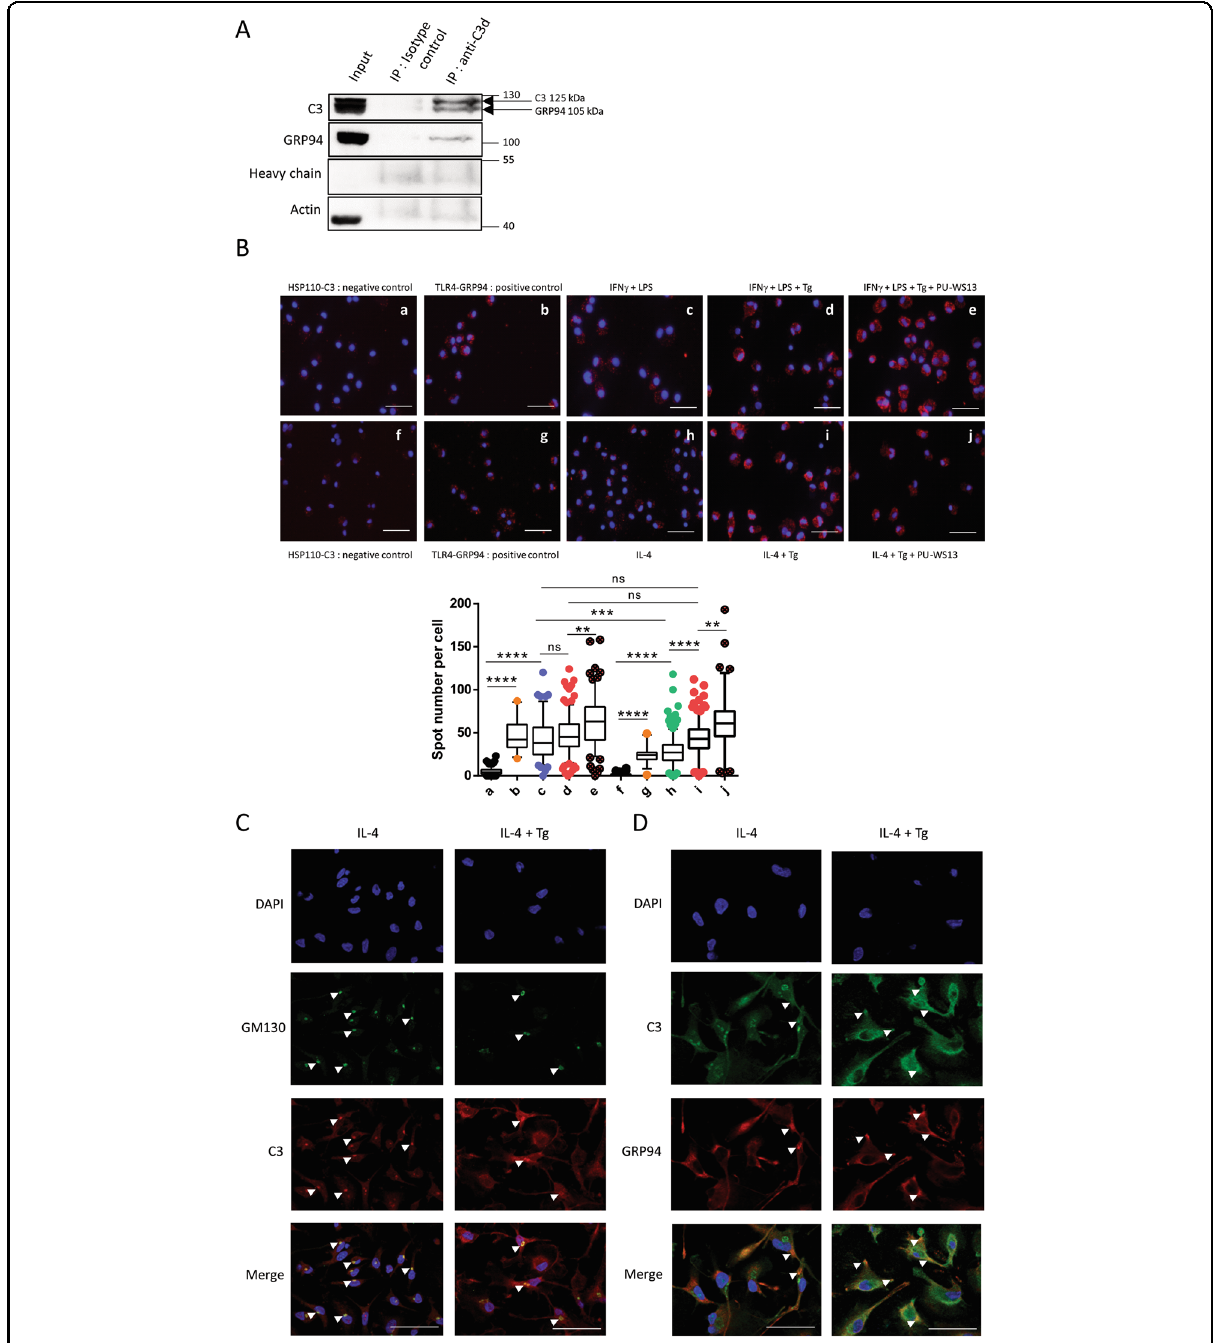
Fig. 5 GRP94-C3 interaction in THP1 cells and in M1 and M2 macrophages derived from monocytes of healthy donors. A Immunoblot of C3 and GRP94 co-immunoprecipitated in THP1 cells using an anti-C3d polyclonal antibody ( n = 3). GRP4 was revealed fi rst then C3, without previous stripping. B Staining and quanti fi cation of proximity ligation assay (Duolink ™ PLA) between C3/C3b and GRP94 in activated M1 and M2 macrophages treated or not with Tg and pretreated or not with PU-WS13 or DMSO as vehicle ( n = 3); the box plot represents the number of spots for each cell analyzed. The boundary of the box closest to zero indicates the 25th percentile, the black line within the box marks the median and the boundary of the box farthest from zero the 75th percentile. Whiskers below and above the box indicate the 5th and 95th percentiles. Points below and above the whiskers indicate outliers outside the 5th and 95th percentiles (* p < 0.05; ** p < 0.01; *** p < 0.005; **** p < 0.001). C Immuno fl uorescence staining of C3/C3b and GM130 in activated M2 macrophages treated or not with Tg ( n = 3, representative images). D Immuno fl uorescence staining of GRP94 and C3/C3b ( n = 3, representative images). White arrows indicate overlapping areas for each labeling. Scale bar = 20 μ